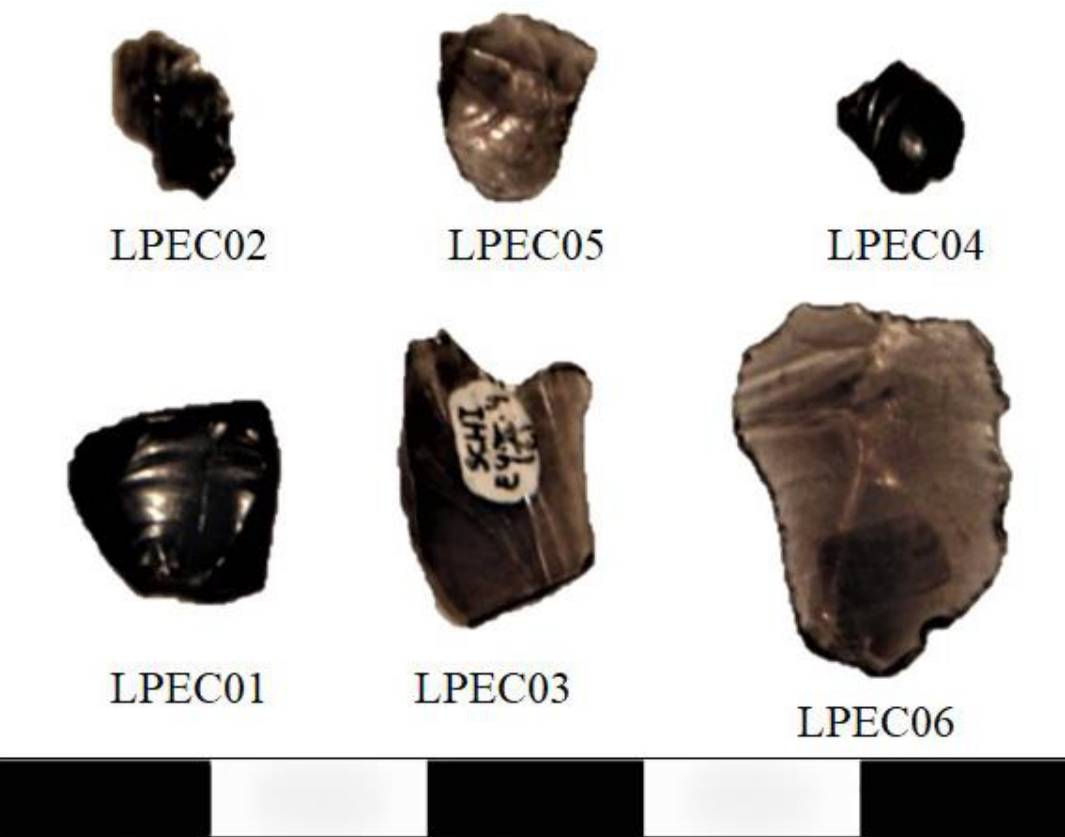
Figure 5. Obsidian artifacts from Chenque I site. Scale bar = 5 cm (1 cm